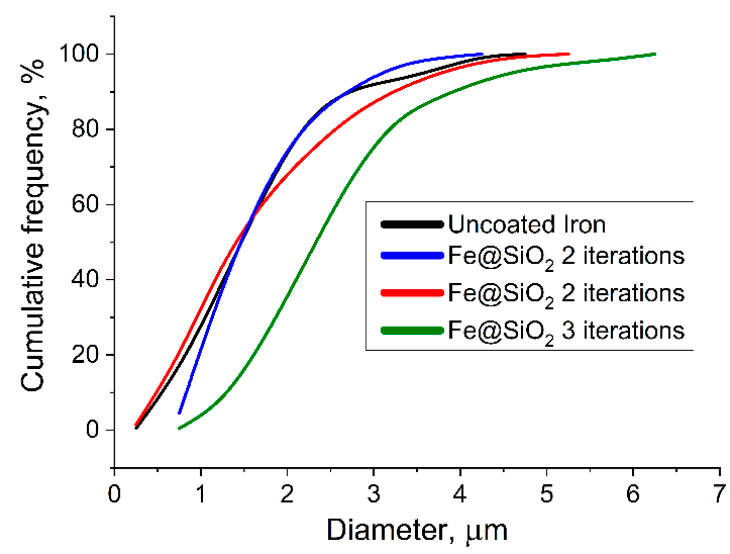
Figure 5. Cumulative particle size curve for uncoated CI; one, two, and three iterations.